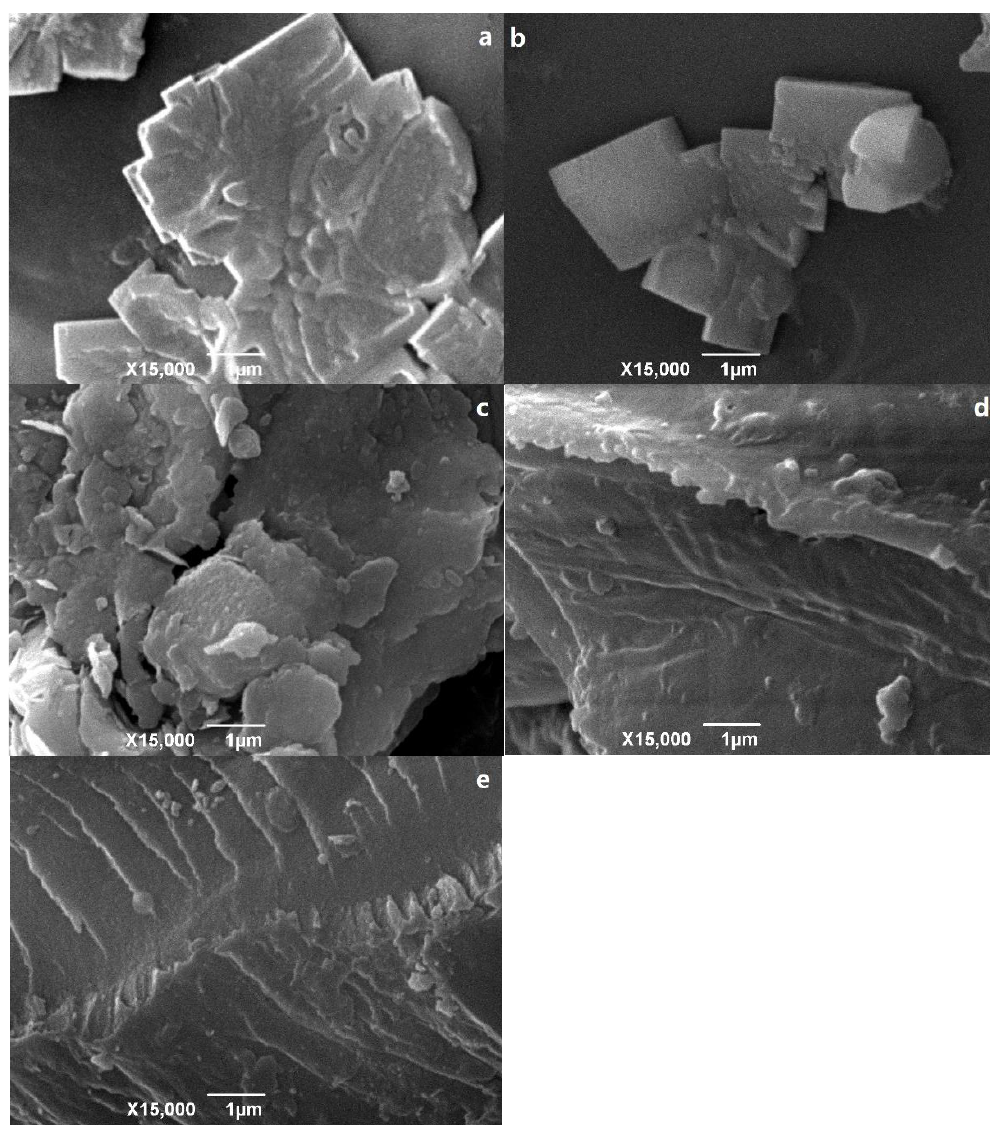
Figure 1. The SEM images of the B ( a ), MB ( b ), BE ( c ), CB ( d ), and the CB after Hg 2+ adsorption ( e ).